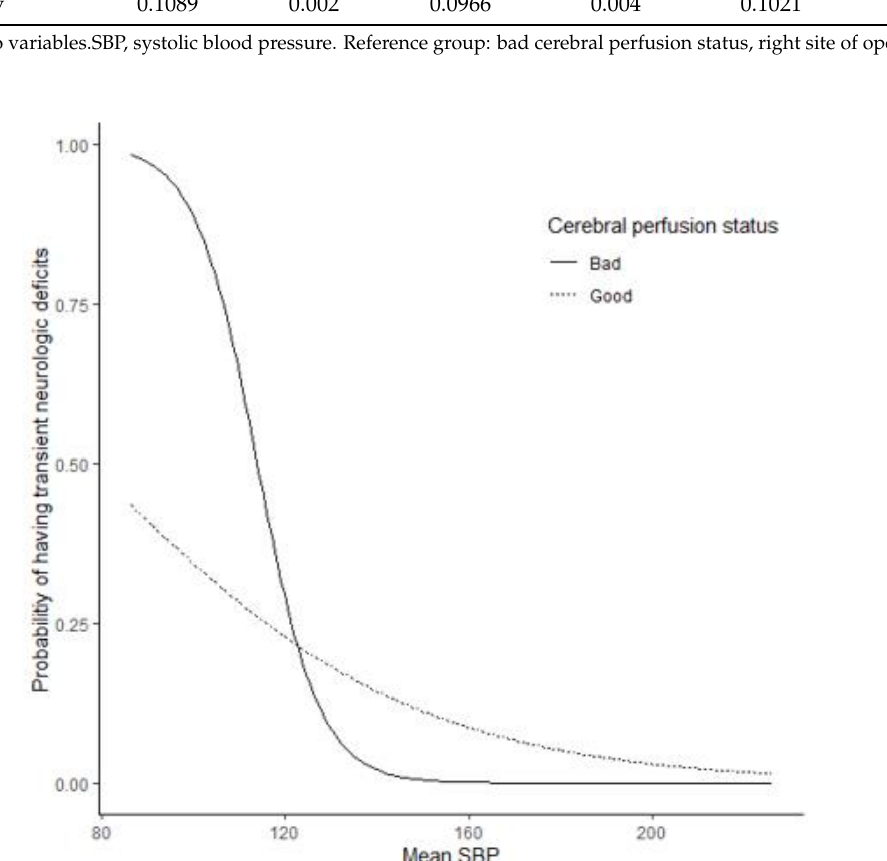
Figure 2. Predicted probabilities of transient neurologic deficits derived from a linear logistic regression model on mean systolic blood pressure (SBP). Poor perfusion was defined as cerebral perfusion within a lower color range on basal SPECT compared with contralateral side and/or the surrounding area, while good perfusion status detected on brain SPECT images was classified as “normal” according to visual assessment by two nuclear medicine physicians.